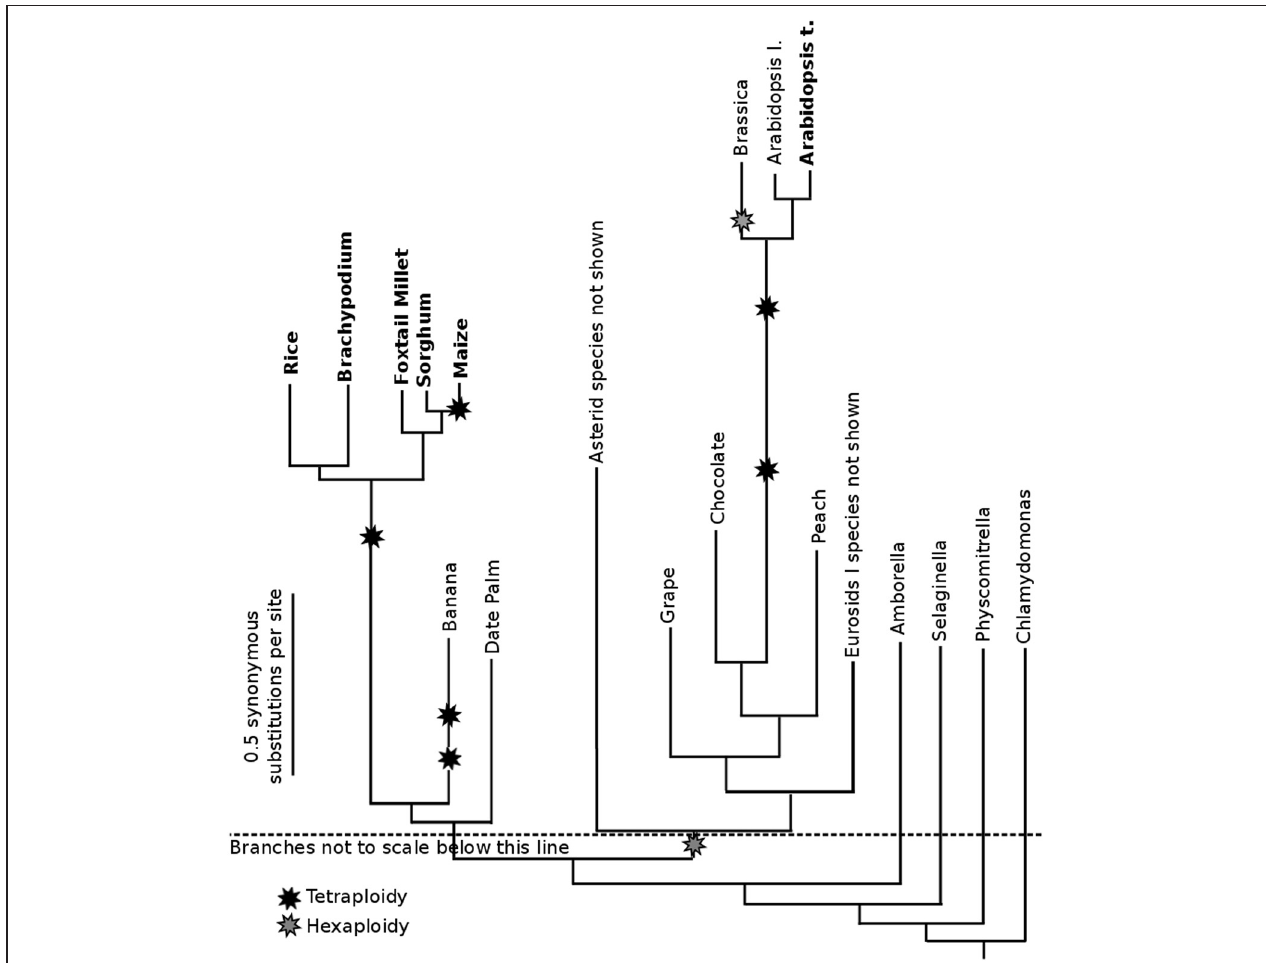
FIGURE 1 | Phylogenetic relationships among published plant whole genomes. Branch lengths are scaled based on the modal number of synonymous substitutions per nucleotide (modal Ks) between the protein coding open-reading-frame of orthologous (or homeologous) genes. The total Ks separating orthologous genes in two species can be assessed looking at the total length of all branch segments traversed to connect the two species names. The total Ks separating homeologs in a given species is the distance from the species name to the starburst representing that whole genome